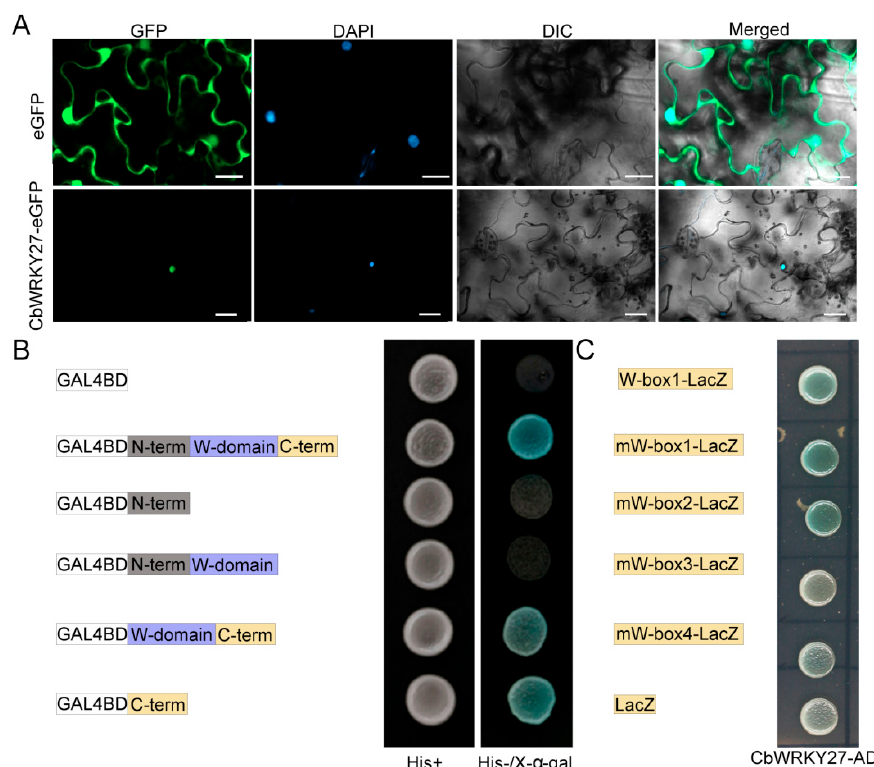
Figure 1. CbWRKY27 functions as a transcription factor. ( A ) Subcellular localization of CbWRKY27 - eGFP in tobacco ( Nicotiana benthamiana ). 35S::eGFP and 35S:: CbWRKY27 -eGFP were transiently expressed in tobacco leaves via agroinfiltration. The nuclei of N. tabacum epidermal cells were stained with 4’,6-diamidino-2-phenylindole (DAPI). Bar = 20 μ m. ( B ) The transcriptional activation activity assay of CbWRKY27 in yeast cells. The C terminus of CbWRKY27 significantly promoted the growth of yeast cells, which was accompanied by a blue tone on selection media with X-gal. ( C ) Y1H assays to determine the binding activity of CbWRKY27 to W-box sequences. W-box and mutant W-boxes (mW-box1-mW-box4) were fused to the upstream region of the LacZ reporter gene. The empty pLacZi was used as a negative control.